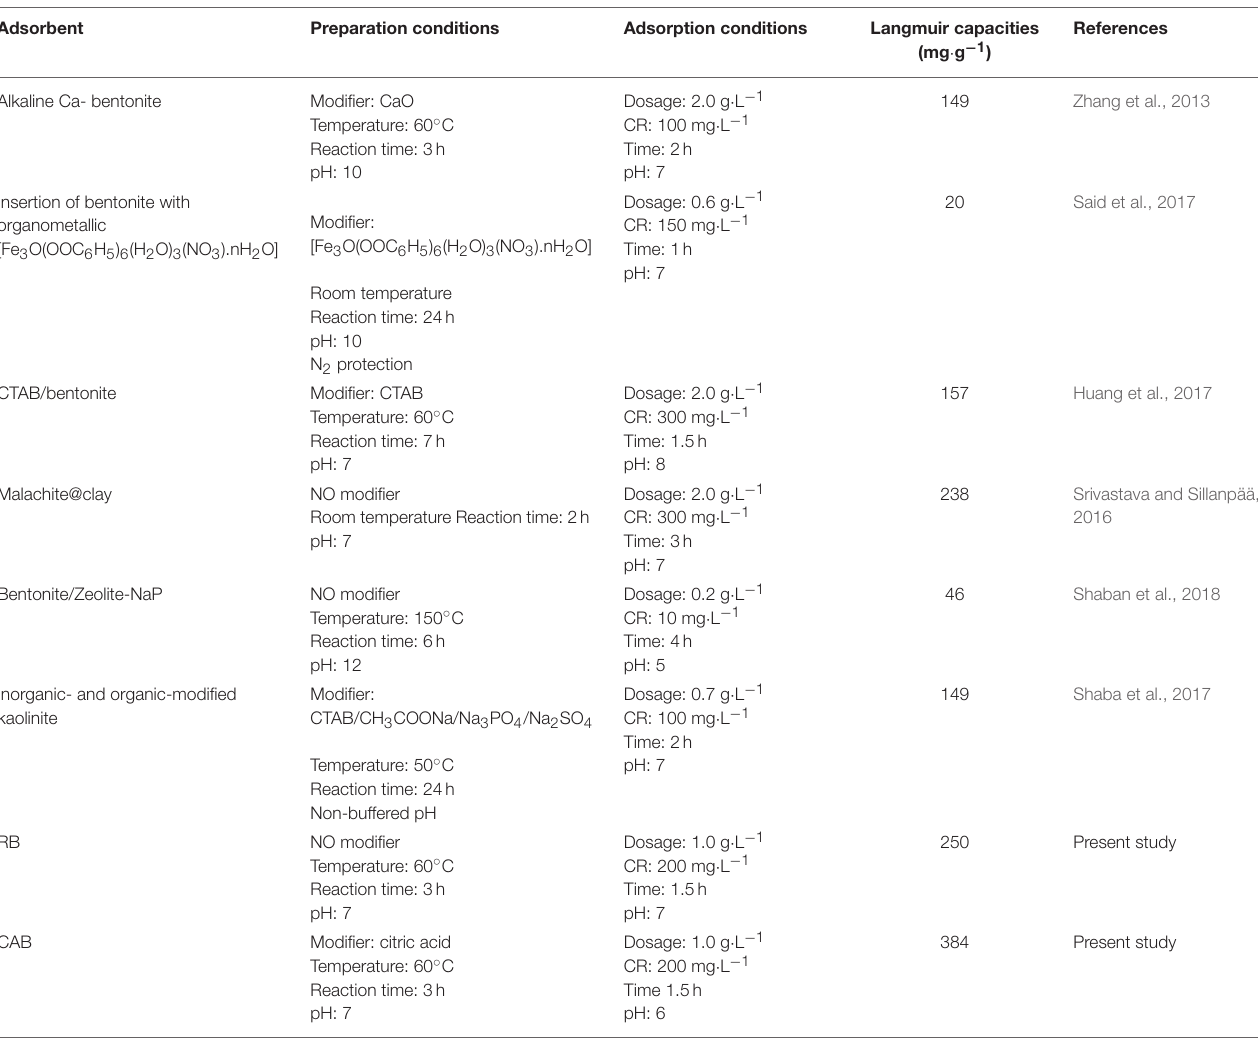
TABLE 2 | Comparison of preparation conditions and adsorption performance of various adsorbents for CR removal. Adsorbent